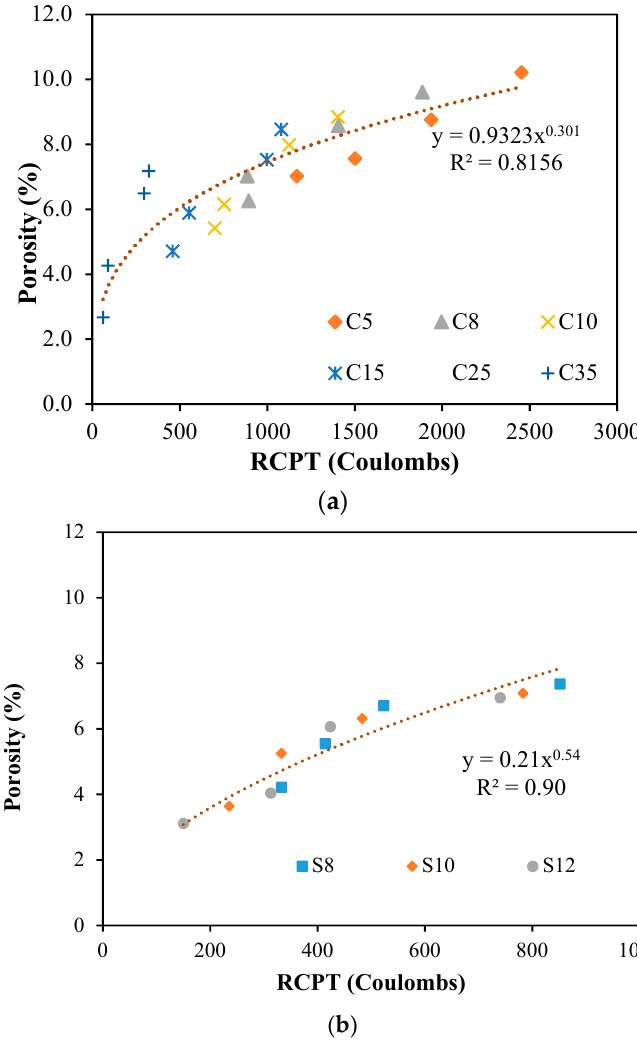
Figure 10. Porosity (%) vs. RCPT (Coulombs) relationship for different dosages SF and UF: ( a ) porosity (%) vs. RCPT (Coulombs) relationship for different dosages UF; ( b ) porosity (%) vs. RCPT (Coulombs) relationship for different dosages SF.